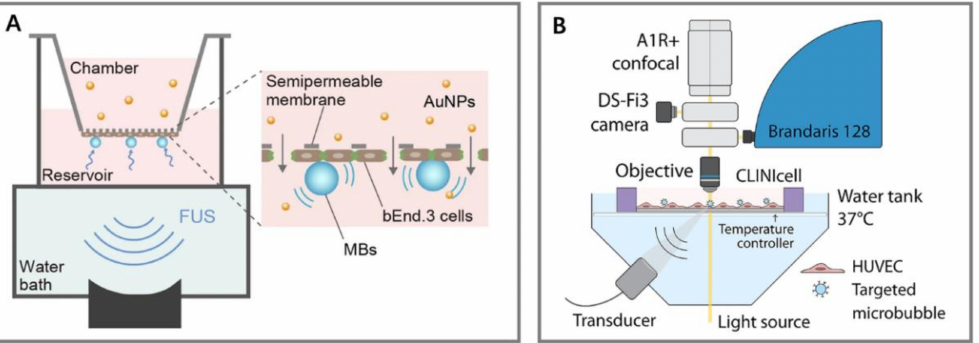
Figure 8. Different kinds of in vitro static systems employed for the study of ultrasound mediated opening of the BBB. ( A ) Ultrasound-driven microbubbles stimulate ECs in the Transwell model [120]. ( B ) Ultrasound stimulates HUVEC in the monolayer culture model